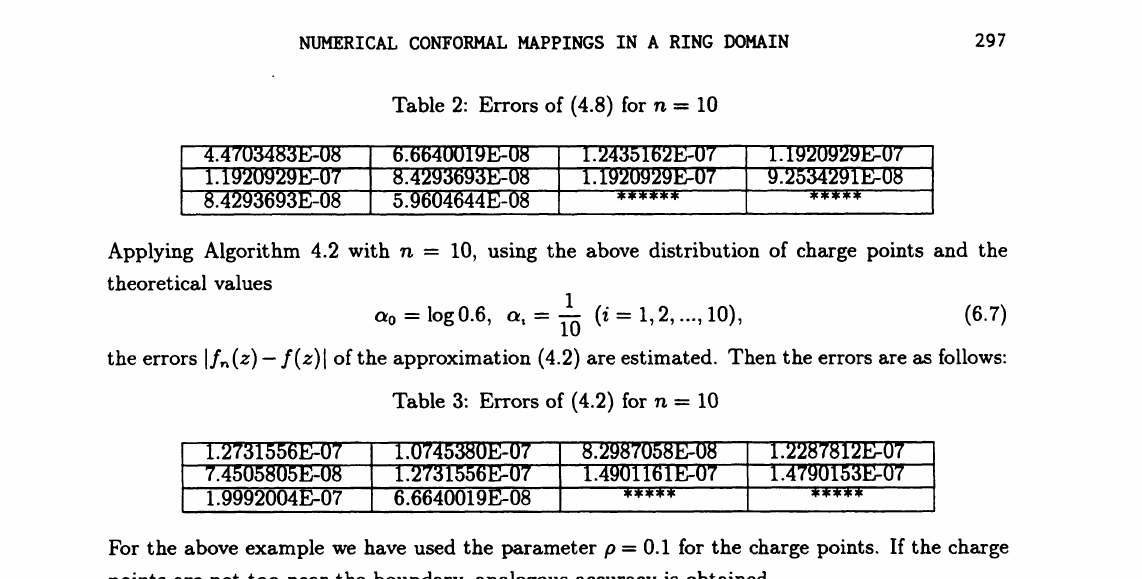
Algorithm 4.4 is applicable when the charge points and collocation points are distributed by the way of